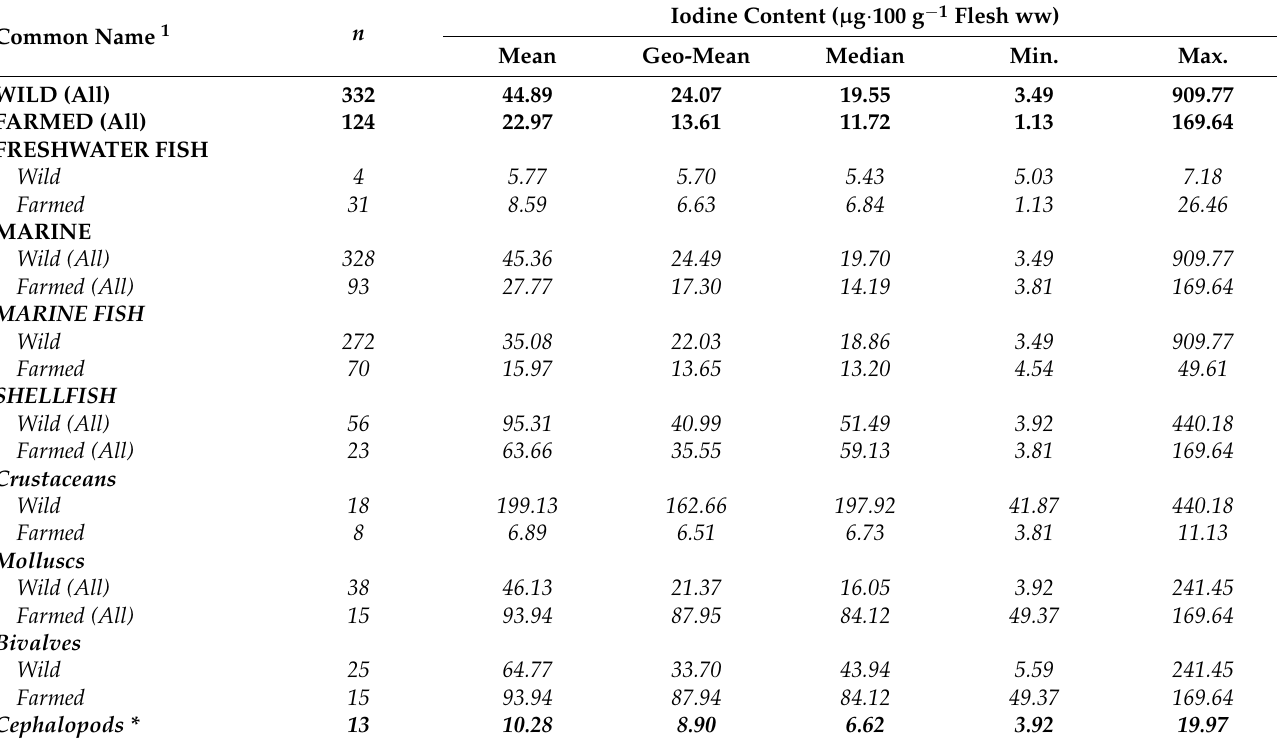
Table 3. Iodine contents ( µ g · 100 g − 1 flesh ww) of wild and farmed seafood in the major seafood